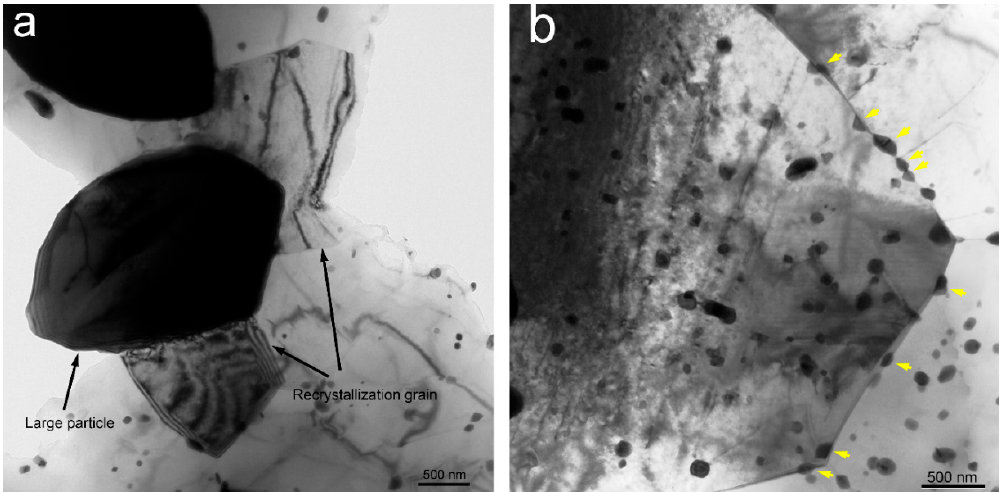
Figure 13. Bright field TEM micrographs taken from as-extruded Mg–4Sm–4Zn–0.5Zr alloy: ( a ) the large particles can promote recrystallization after hot extrusion; ( b ) fine and dispersive particles can pin the grain boundaries.